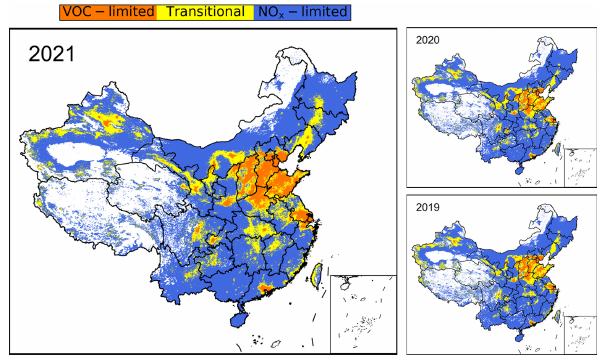
Figure 4. Ozone sensitivity classification in the study area from April to September 2019–2021 using different HCHO / NO 2 thresh- olds in different regions. Only polluted regions are displayed (defined as average TROPOMI NO 2 columns higher than 1 . 0 × 10 15 molec.cm − 2